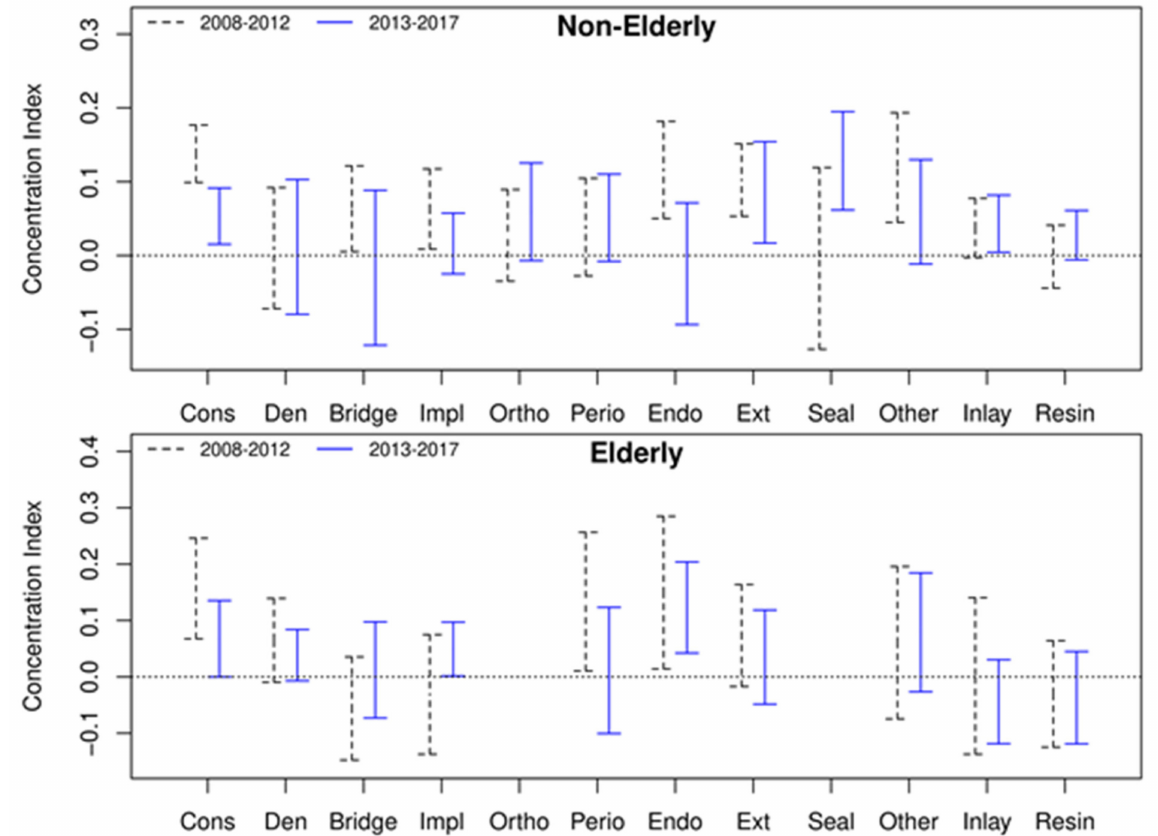
Figure 3. Concentration indices for out-of-pocket expenses of dental treatments by age groups. Cons: Conservative treatment; Den: Denture; Bridge: Fixed bridge; Impl: Dental implant; Ortho: Orthodontic treatment; Perio: Periodontal treatment; Endo: Endodontic treatment; Ext: Extraction; Seal: Sealant; Inlay: Gold inlay; Resin: Resin